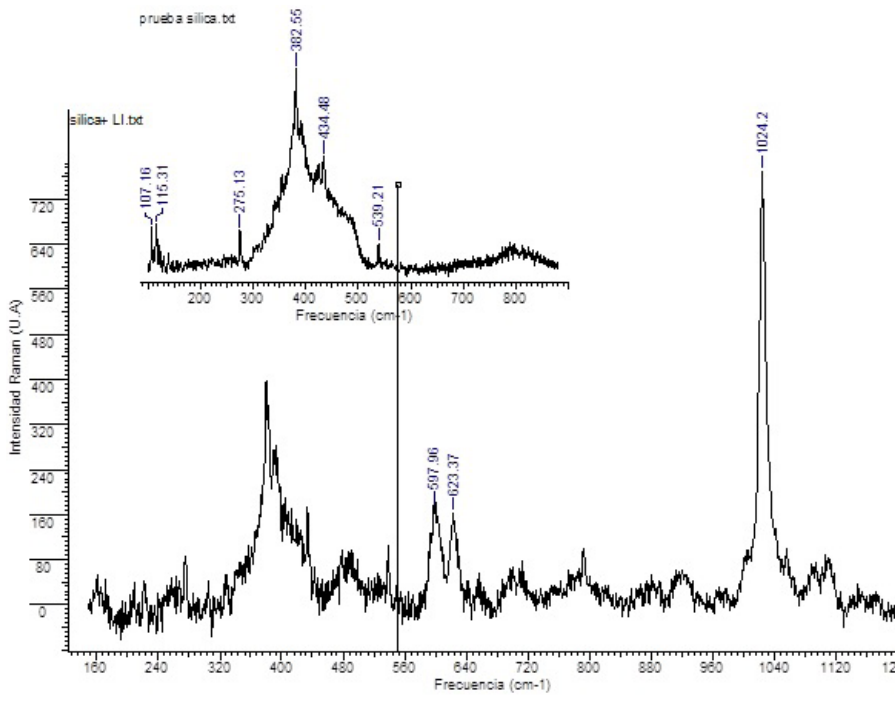
and ionic liquid immobilized on SiO 2